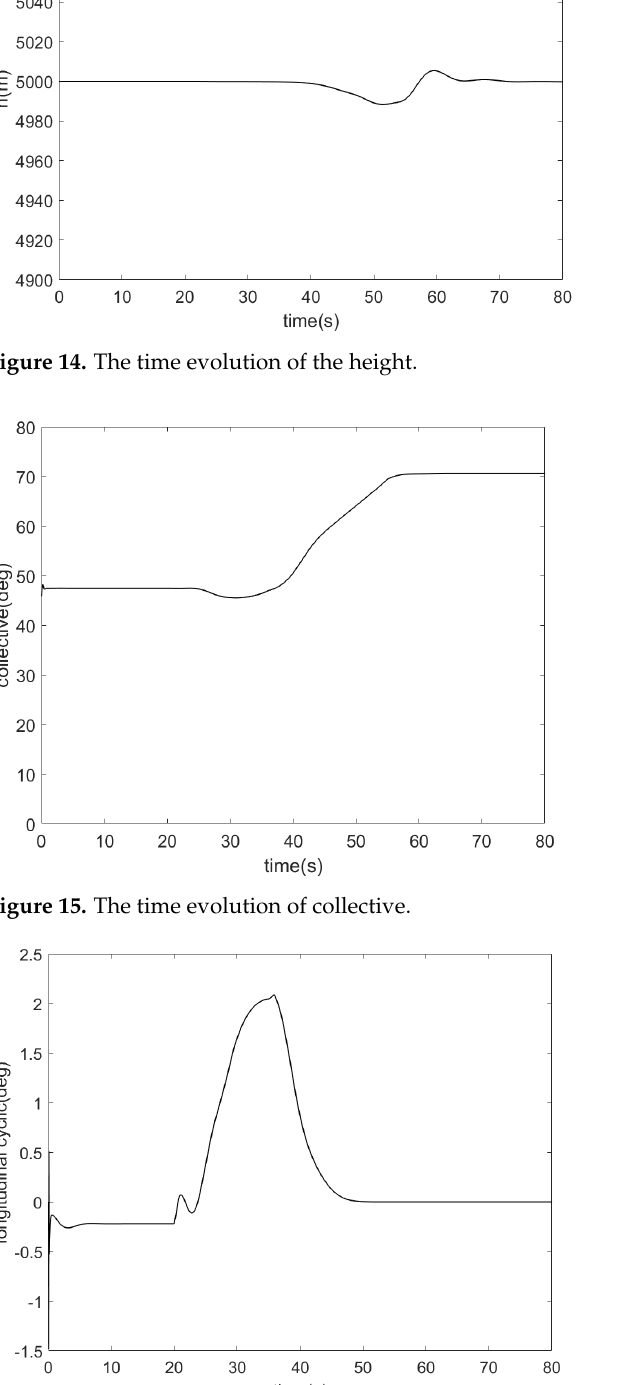
Figure 16. The time evolution of longitudinal